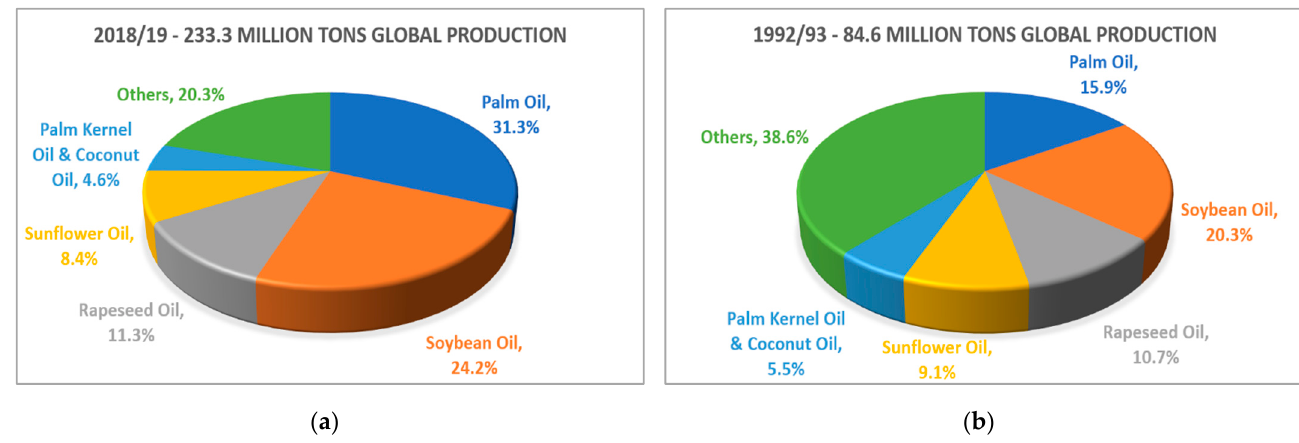
Figure 1. Market shares of 17 edible oils and fats produced internationally in: ( a ) 2018/19 and; ( b ) 1992/93. Created with data from [1]. Table 1. Average productivity of various major oil crops. Created with data from [3,4].